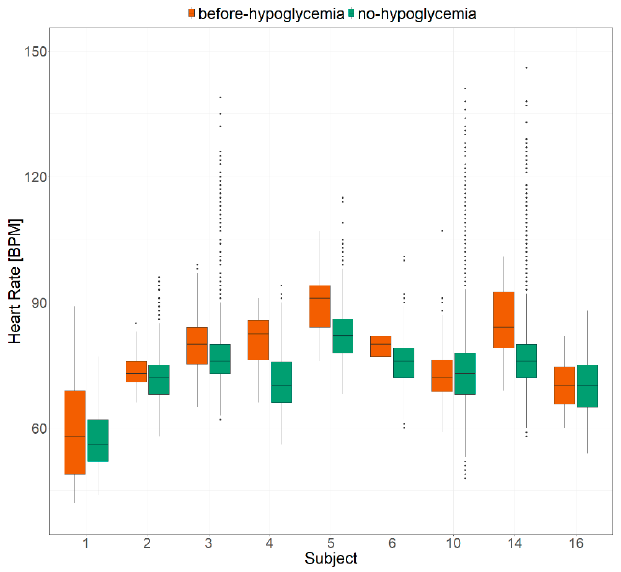
Figure 1. Comparison between the heart rate values collected in the hour before a hypoglycemic episode (in red) and in sleep intervals without hypoglycemic episodes (in green).